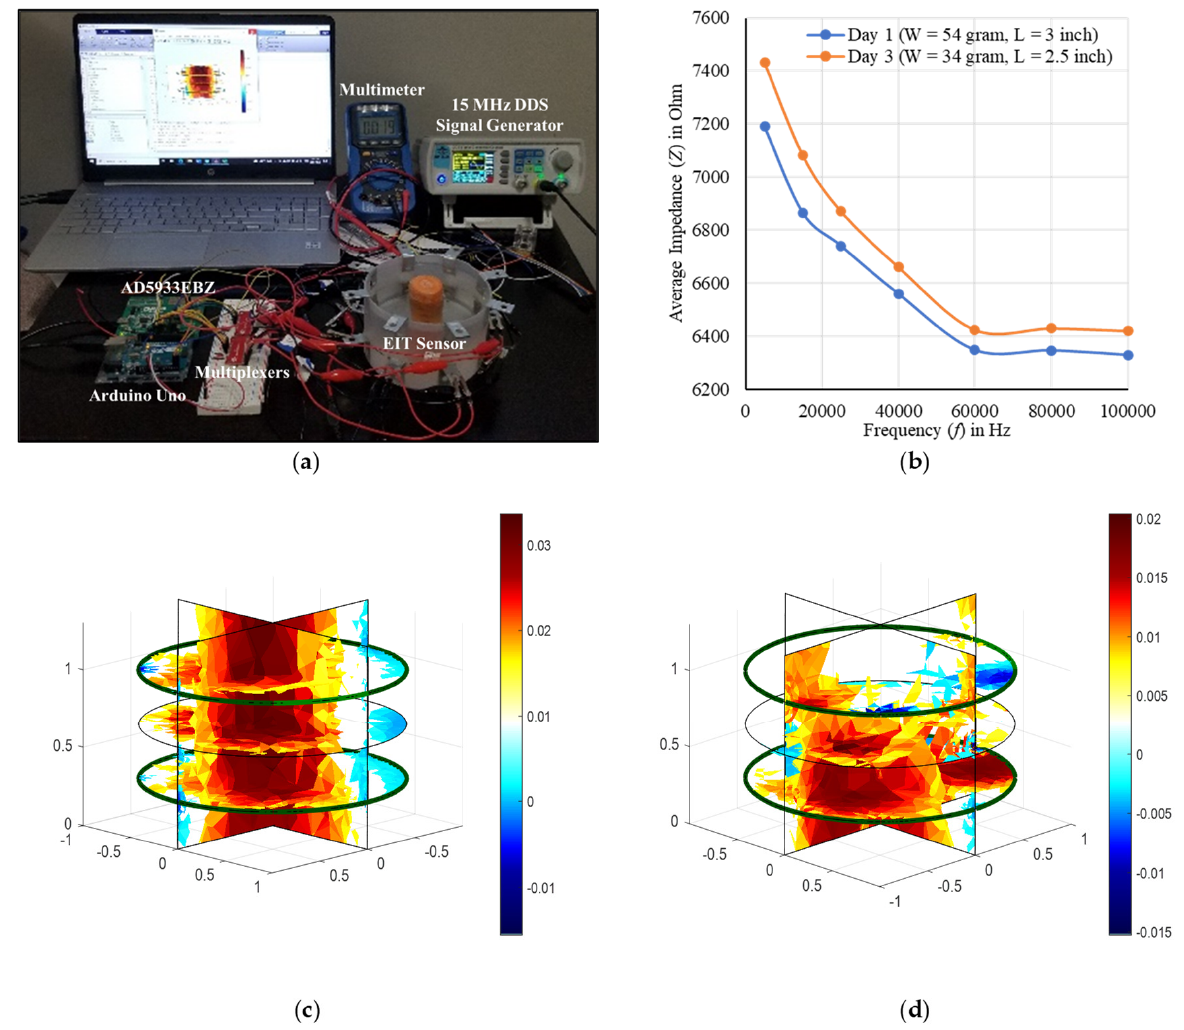
Figure 16. ( a ) A 3D EIT experimental setup for obtaining impedance tomography of a carrot sample (tap root) in a cylindrical domain. ( b ) Average impedance profile of the sample by varying frequency in different days (day 1 and day 3). The reconstructed images of the sample obtained in ( c ) day 1, and ( d ) day 3 at 80 kHz, 1 mA, and 2 Vpp excitation considering GN: NOSER ( λ = 2.17). The average impedance of the carrot is decreased with the increase in frequency and the impedance is increased at different frequencies with time. The maximum conductivity of the sample is decreased from 0.033 to 0.02 by reducing the biomass weight and dimension with time. It is found that biomass of a carrot has dimensional dependency.